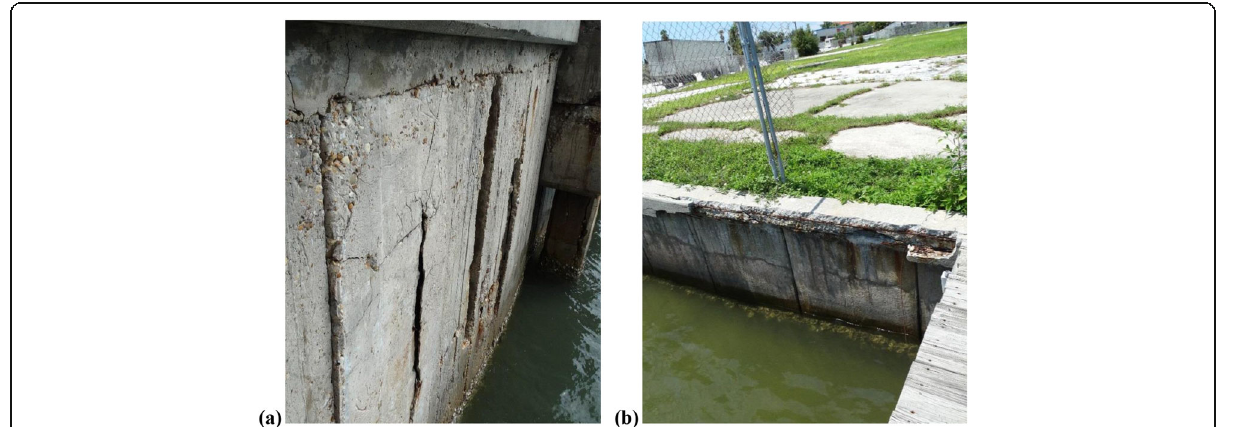
Fig. 2 Typical examples of severe corrosion damage on concrete seawalls [95]